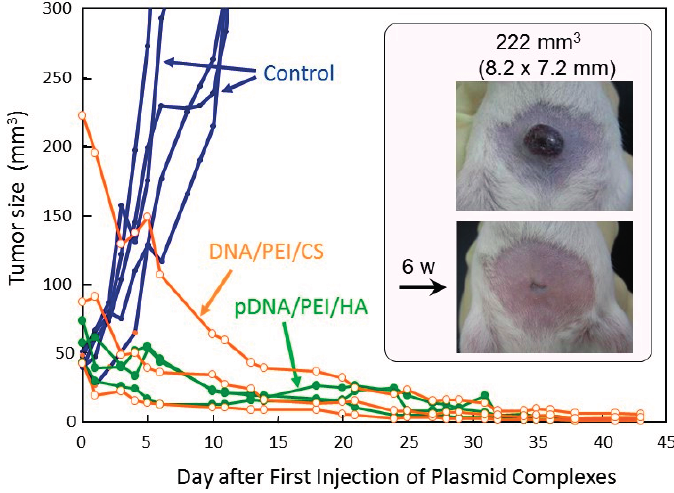
Figure 9. Therapeutic efficacy of DNA(GM-CSF)/(PEI “Max”)/HA (or CS) complexes (1:12:12) in tumor-bearing